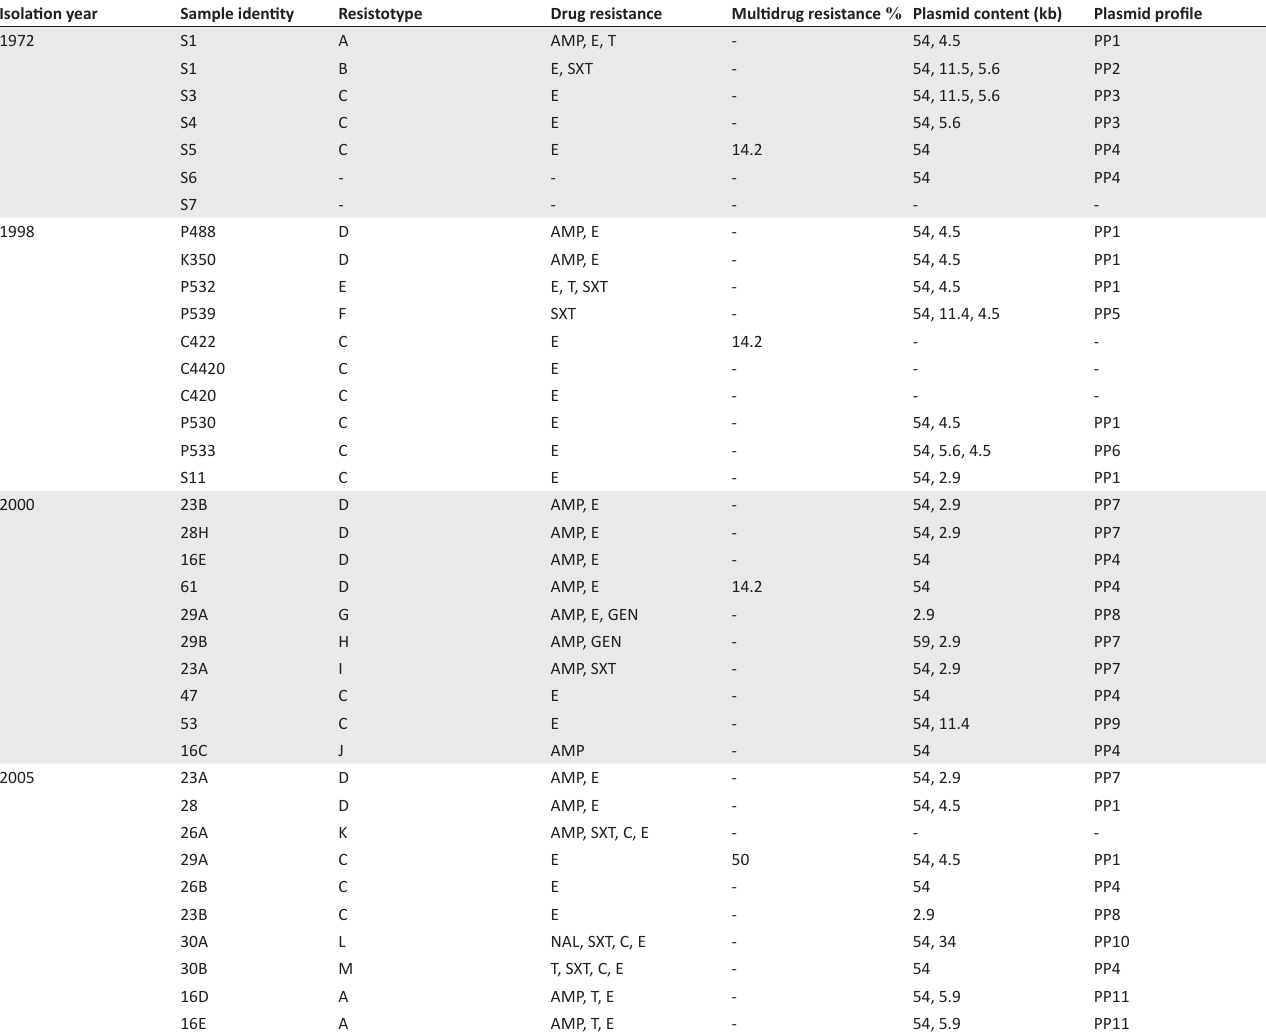
TABLE 2: Antimicrobial resistance patterns and plasmid profiles of Salmonella enteritidis isolates obtained from the Central Veterinary Laboratory (1972–2005). Isolation